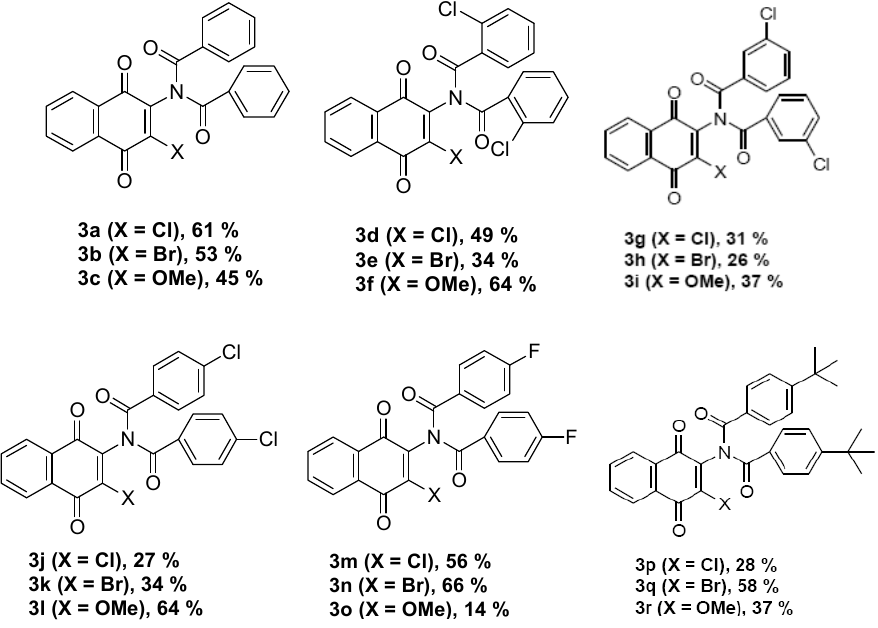
Figure 2. Structures of 3-halo- or 3-methoxy-substituted 2-dibenzoyl-amino-1,4- naphthoquinone